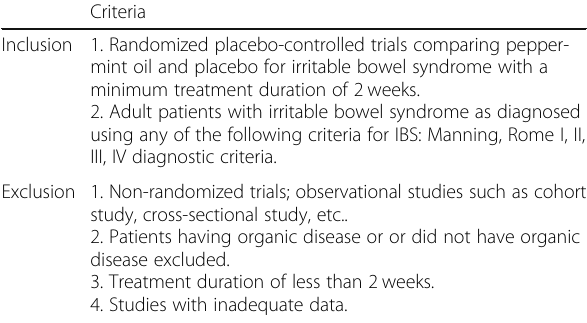
Table 1 Selection criteria for inclusion and exclusion